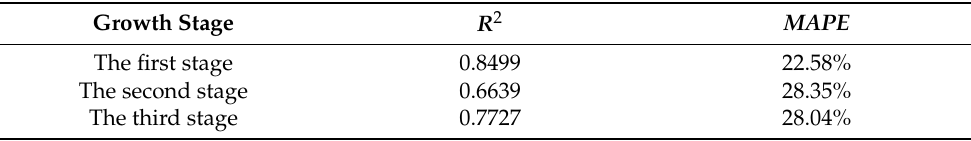
Table 11. R 2 and MAPE for the SVR dry weight